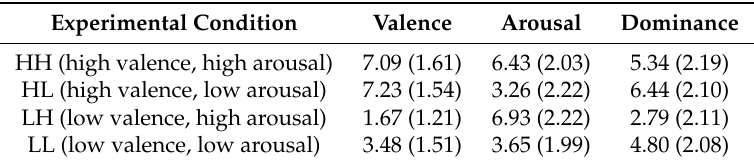
Table 1. Mean value and standard deviation for valence, arousal and dominance of each group of International Affective Picture System (IAPS) images.